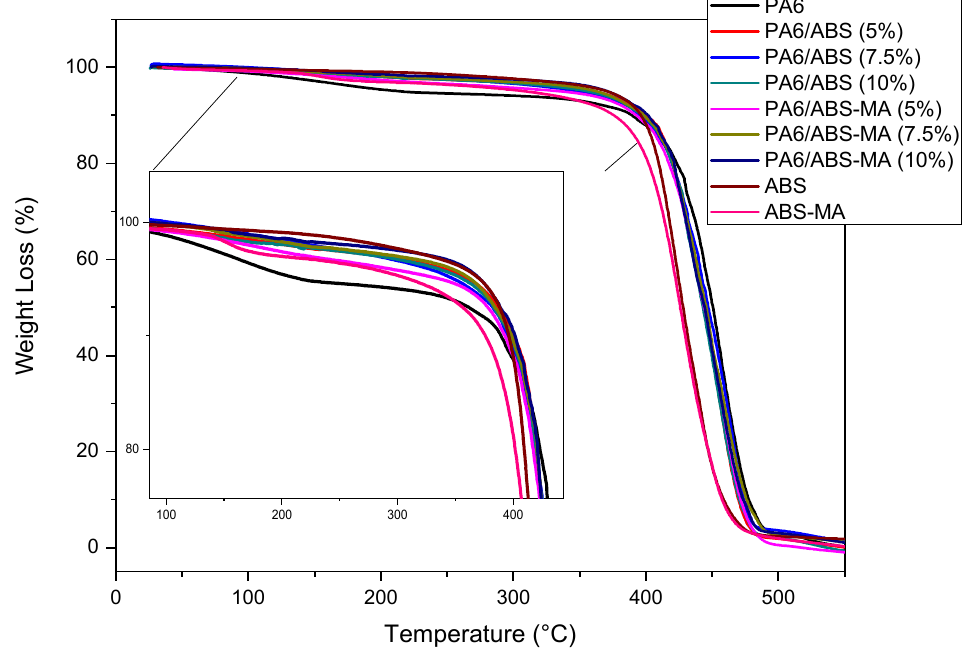
Figure 17. TG curves for pure PA6 and its binary blends.